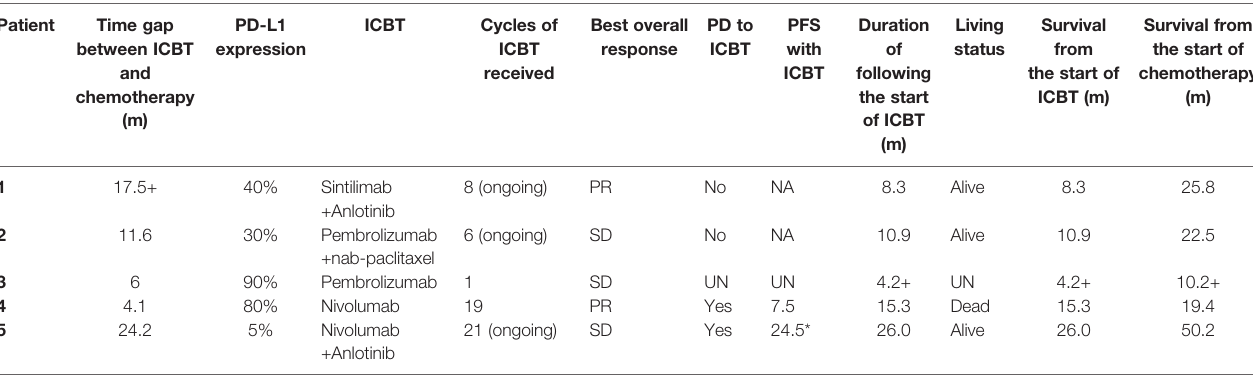
TABLE 3 | Treatment details of immune checkpoint blockade therapy. Patient Time gap between